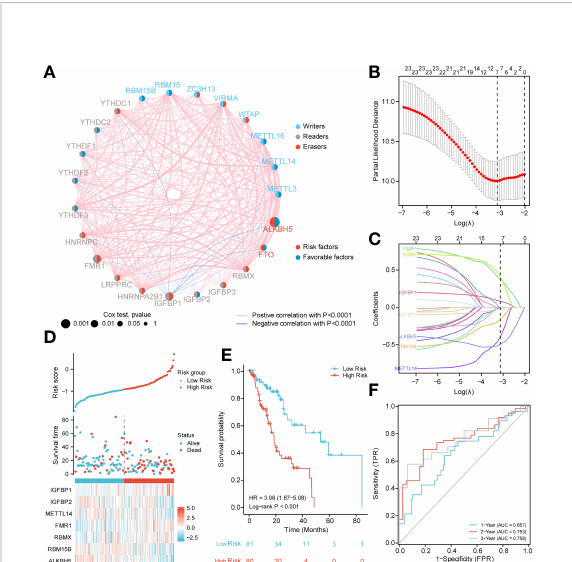
FIGURE 2 PPI network and prognostic signatures construction and prediction. (A) Interaction among m6A-related regulators. Circle size indicates the effect of each gene on survival, the larger the size, the greater the effect; on the right half of the circle, red represents risk prognostic factors and blue represents favorable factors; on the left side of the circle, red represents recognition proteins (readers), blue represents methyltransferases (writers), and brown demethyltransferases (erasers); lines that connect genes exhibit genetic interactions, red and blue represent positive and negative associations, respectively. (B) Partial likelihood deviance of different numbers of variables. One- thousand-fold cross-validation was applied for tuning penalty parameter selection. (C) LASSO analysis identi fi ed seven m6A- related genes in the 23 m6A-related regulators cohort. Each curve corresponds to one gene (cyan, FMR1; green, RBMX; pink, IGFBP1; brown IGFBP2; blue, ALKBH5; orange, RBM15B; purple, METTL14). (D) Risk score, distribution of patient survival status between the low- and high − risk groups, and expression heat maps of seven m6A-related regulators. (E) Kaplan – Meier curves indicated that there is a strong relationship between high and low m6Ascore and the overall survival rate. (F) ROC curve was applied to assess the predictive ef fi ciency of the prognostic risk